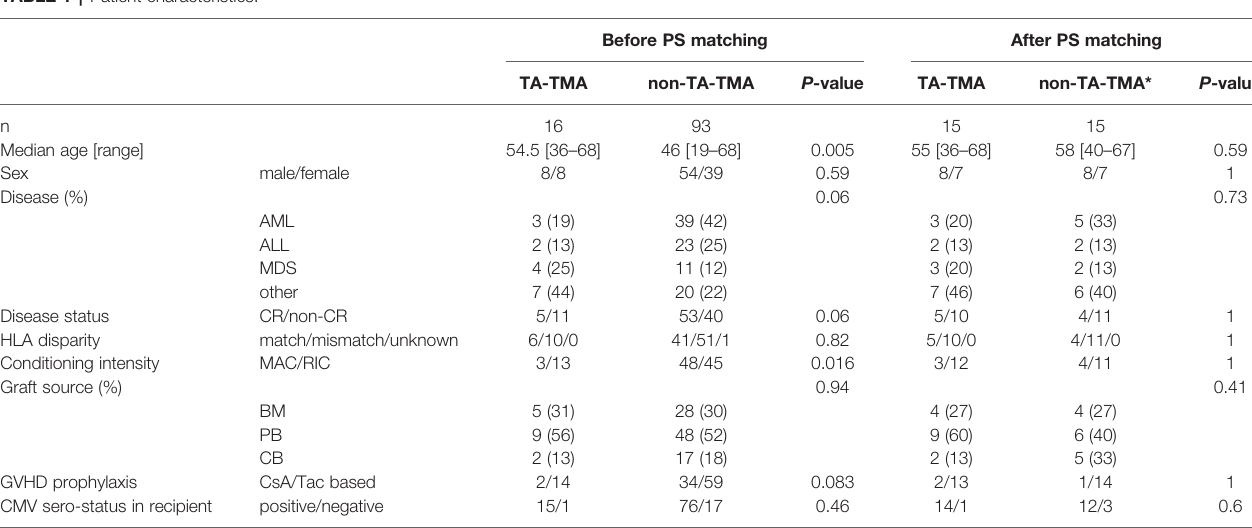
TABLE 1 | Patient characteristics.